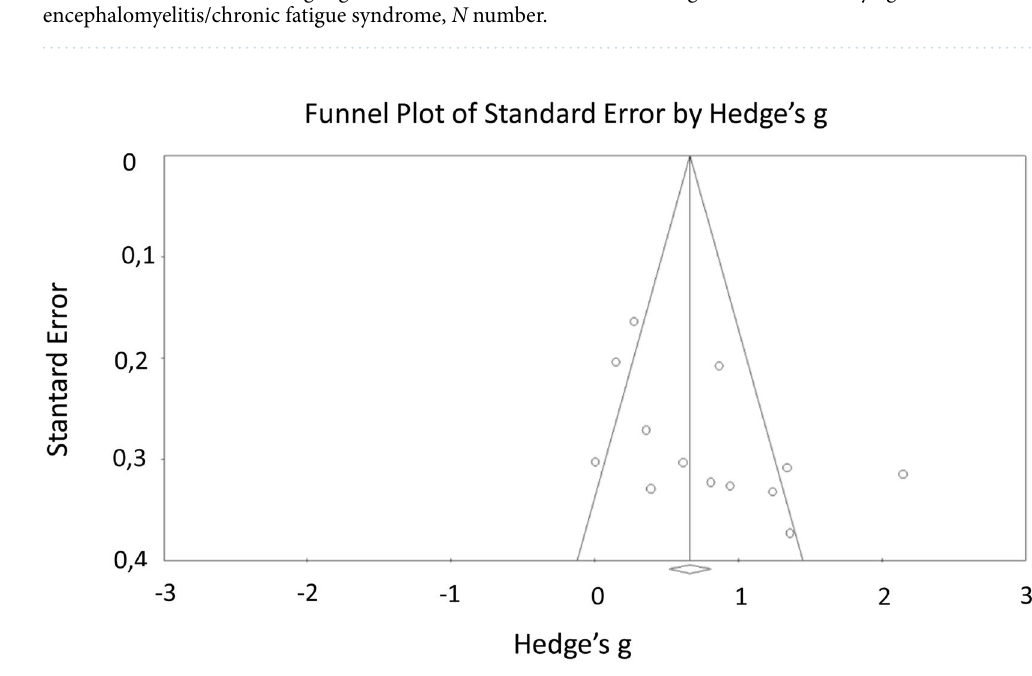
Figure 2. Funnel plot of standard error by Hedge’s g for simple reaction